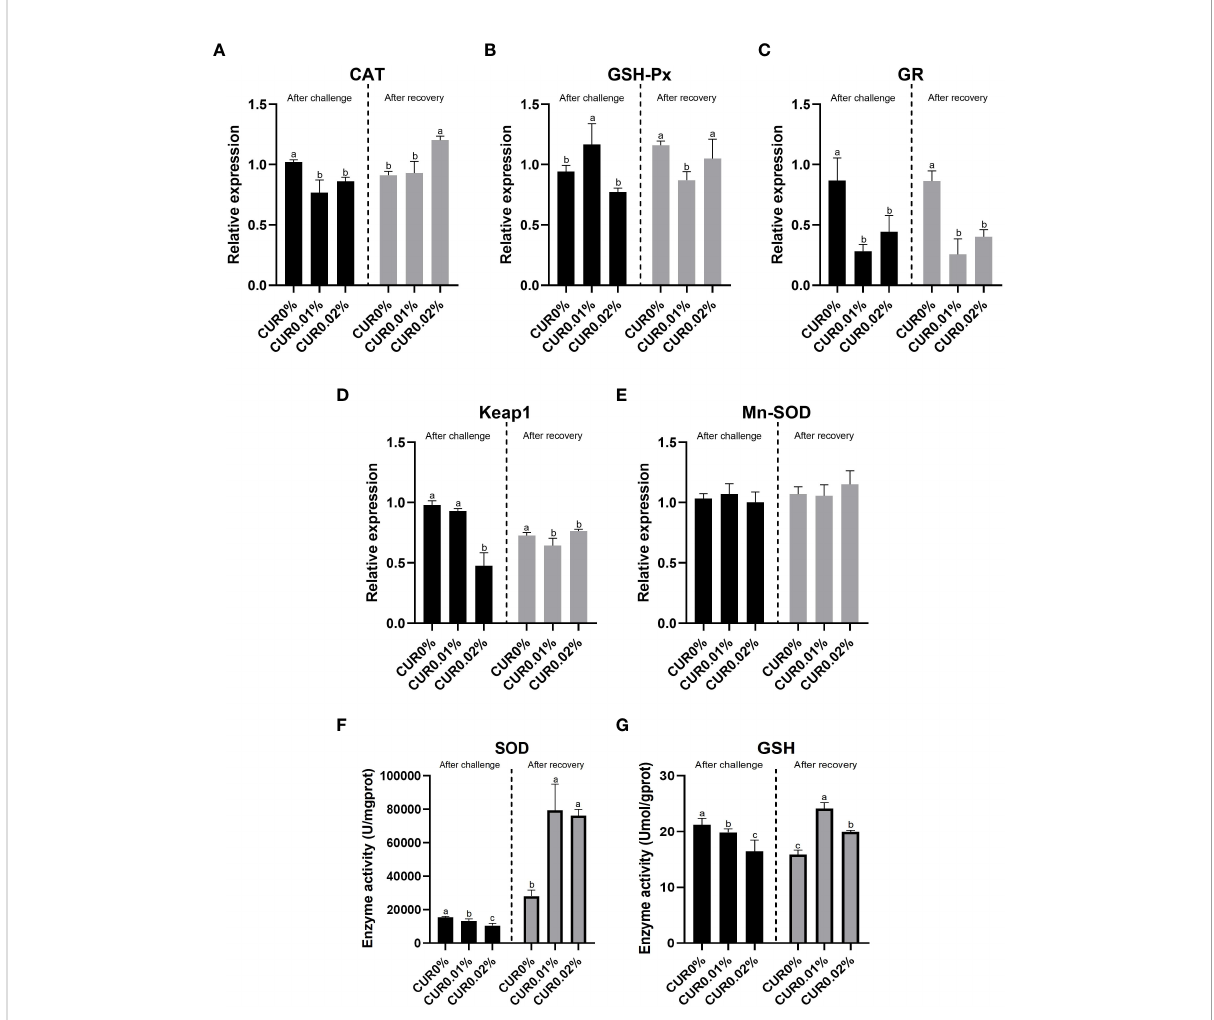
FIGURE 4 The relative expression of CAT (A) , GSH-Px (B) , GR (C) Keapl (D) Mn-SOD (E) gene and the enzyme activity of SOD (F) , GSH (G) in liver tissue of the greater amberjack subjected to ammonia challenge experiment and recovery experiment. Different letters above bars indicate signi fi cant differences at the 0.05 level. Data are expressed as the means ± SD